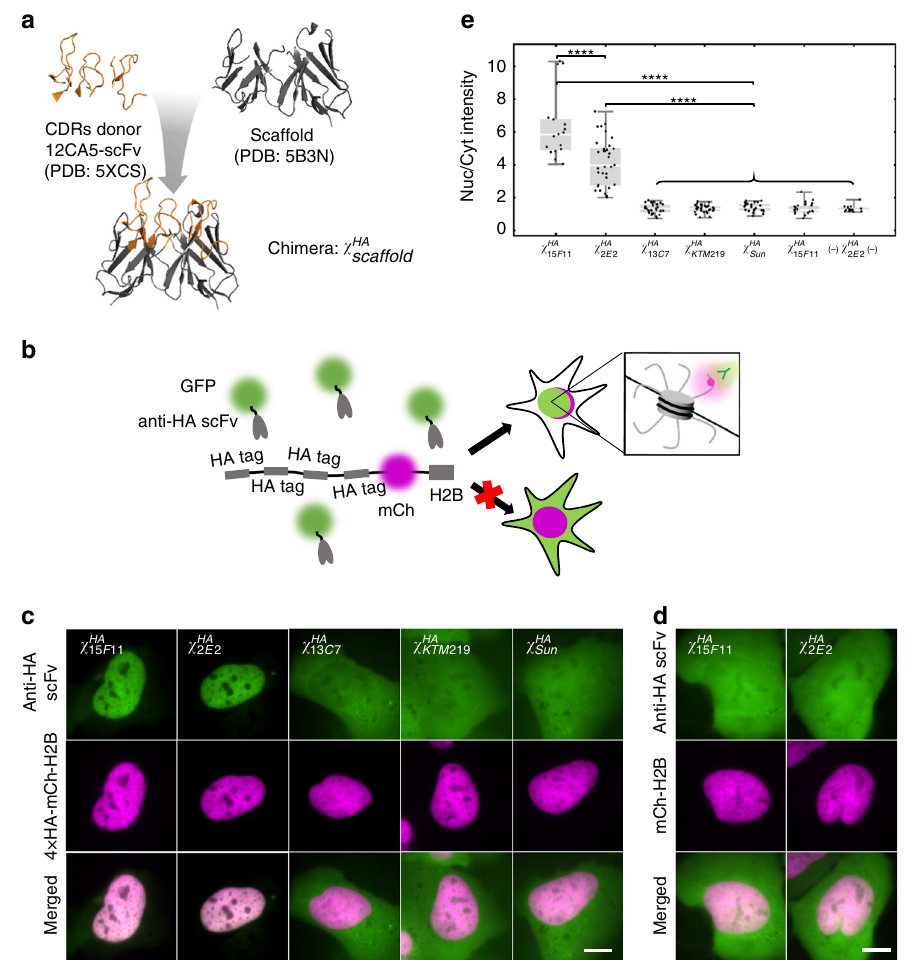
Fig. 1 Design strategy and initial screening of frankenbodies. a A cartoon schematic showing how to design a chimeric anti-HA scFv using 12CA5-scFv CDRs and stable scFv scaffolds. b A cartoon showing how to screen the fi ve chimeric anti-HA scFvs in living U2OS cells. c Initial screening results showing the respective localization of the fi ve chimeric anti-HA scFvs in living U2OS cells co-expressing HA-tagged histone H2B (chimeric anti-HA scFv, green; 4 × HA-mCh-H2B, magenta). From left to right, n = 17, 33, 27, 31, 25 cells. d Control results showing the respective localization of χ HA lacking HA-tagged histone H2B (chimeric anti-HA scFv, green; mCh-H2B, magenta). From left to right, n = 21, 15 cells. e Nuclear to cytoplasmic fl uorescent intensity ratio (Nuc/Cyt) plot of each chimeric anti-HA scFv for all cells imaged as in c and d . Student ’ s t -test. **** p < 0.0001. All images are representative cell images from one independent experiment. Scale bars: 10 µ m. Source data are provided as a Source Data fi le. For the box and whisker plots, median is shown by a white line, the box indicates 25 – 75% range, and whiskers indicate 5 – 95% range Table 1 Sequence identity analysis Scaffolds CDRs donor